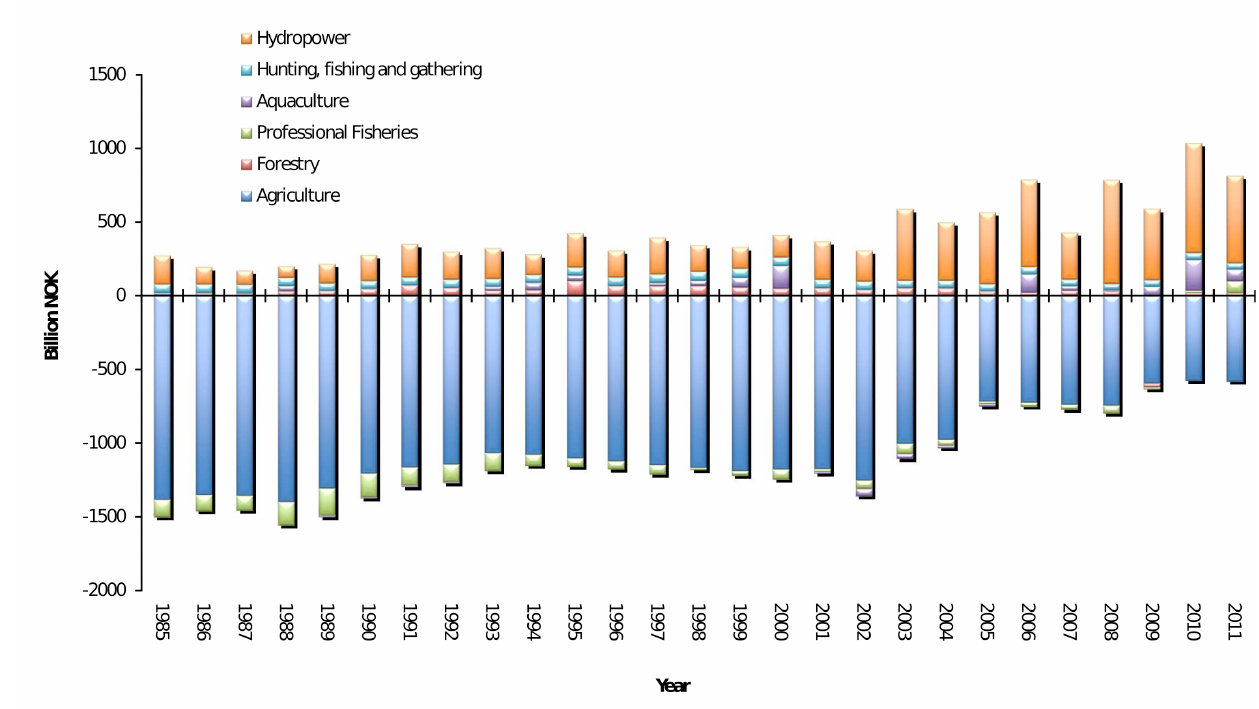
Figure 1. Development of renewable natural capital in Norway 1985–2011.